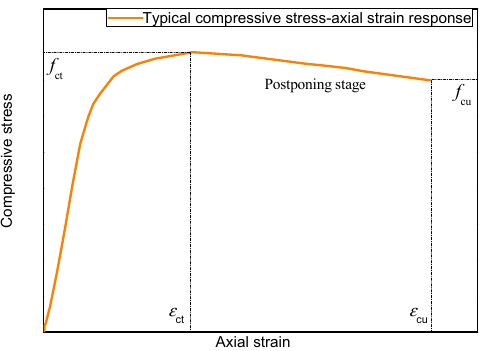
Figure 8. The typical stress–strain relationship of JFRP–RAC and JFRP–SFRAC.